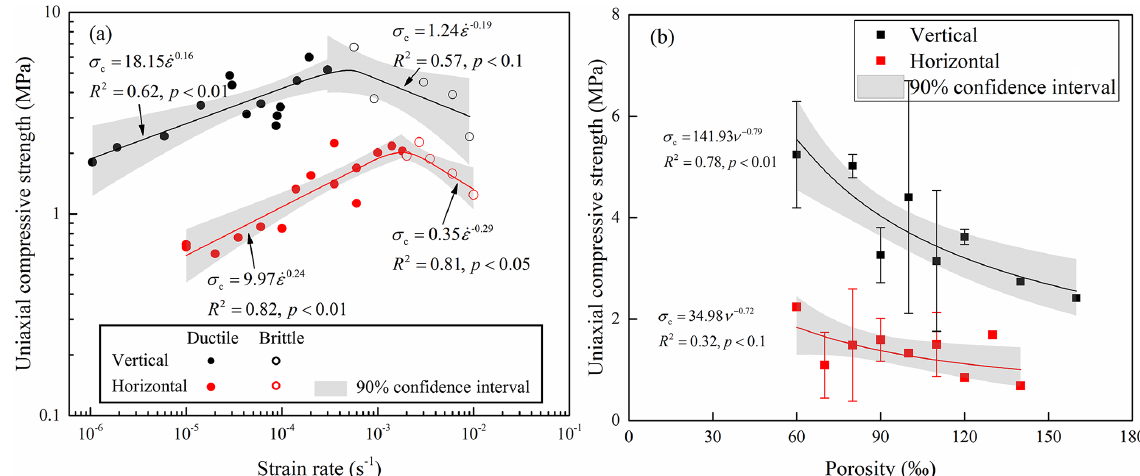
Figure 10. Variations of uniaxial compressive strength with strain rate (a) and porosity (b) for congelation ice. Panel (a) adopts all measured data and (b) adopts averages determined taking the porosity of 10‰ as a bin. Also shown are the best-fit lines and equations, in which the confidence interval is determined using the maximum significance level of the regression